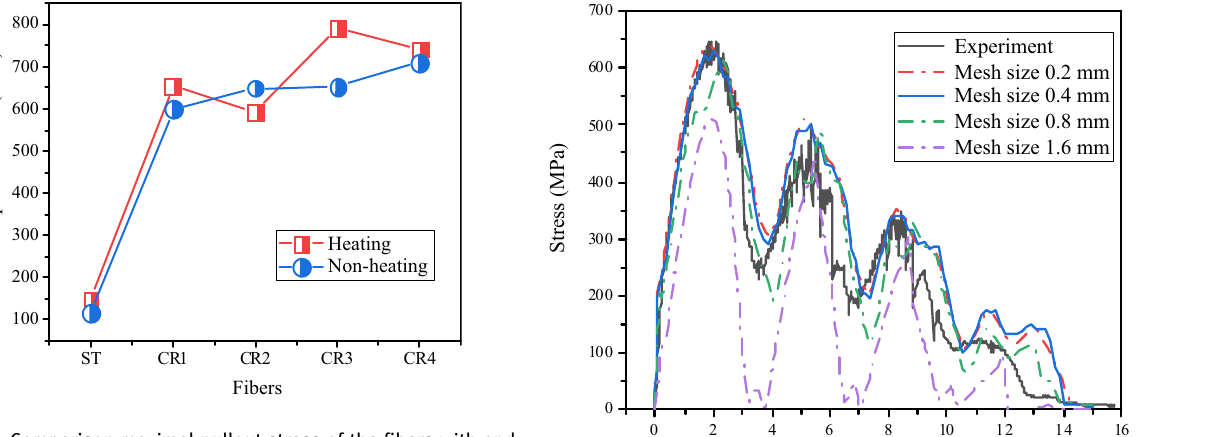
Figure 7: Comparison maximal pullout stress of the fi bers with and without heating.